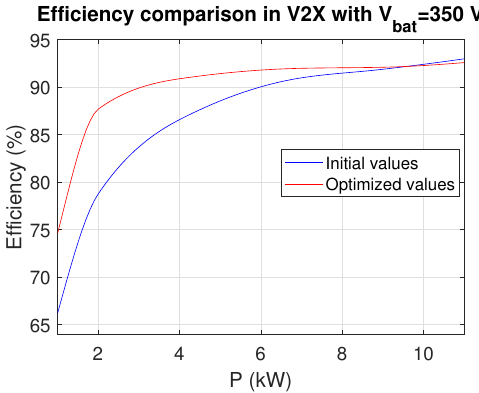
Figure 20. Efficiency comparison in V2X mode with V bat = 350